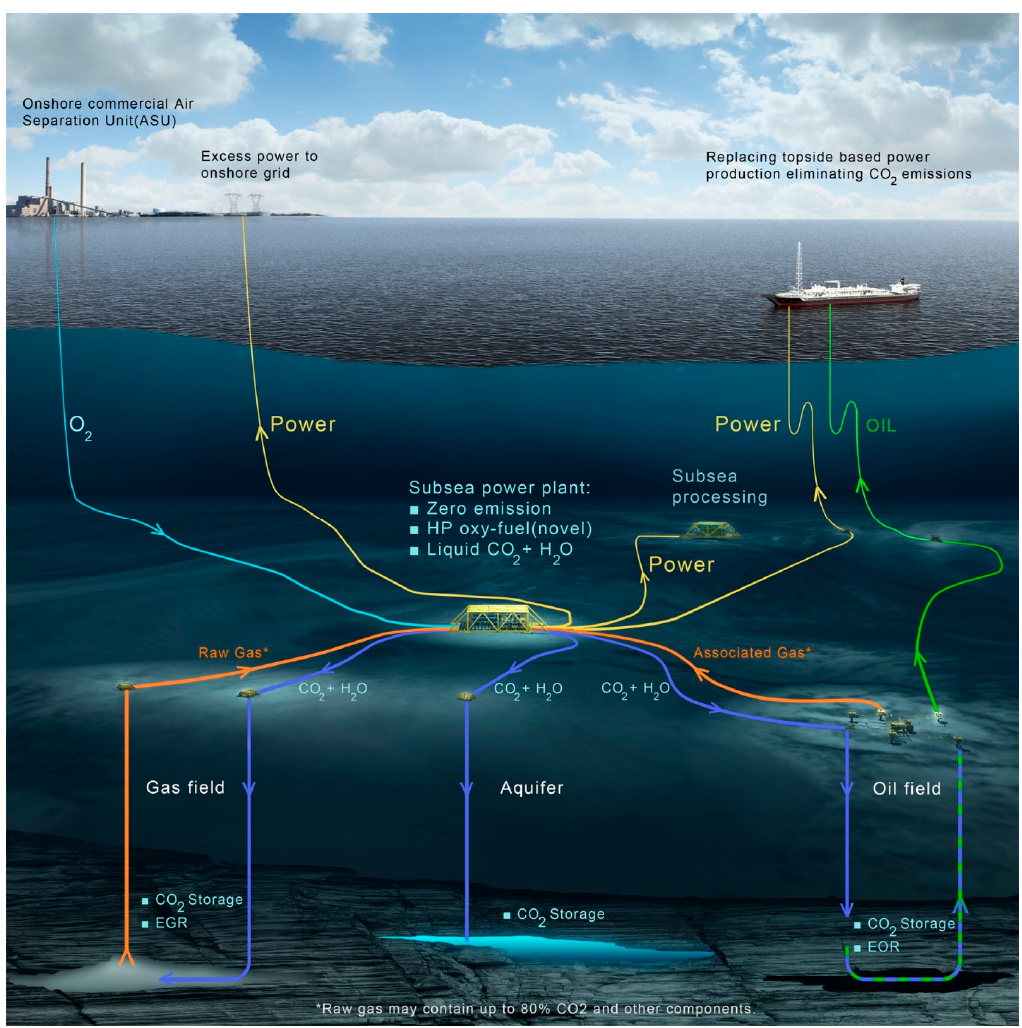
Figure 11. Concept for subsea zero-emission offshore power generation concept (courtesy Aker Solutions).